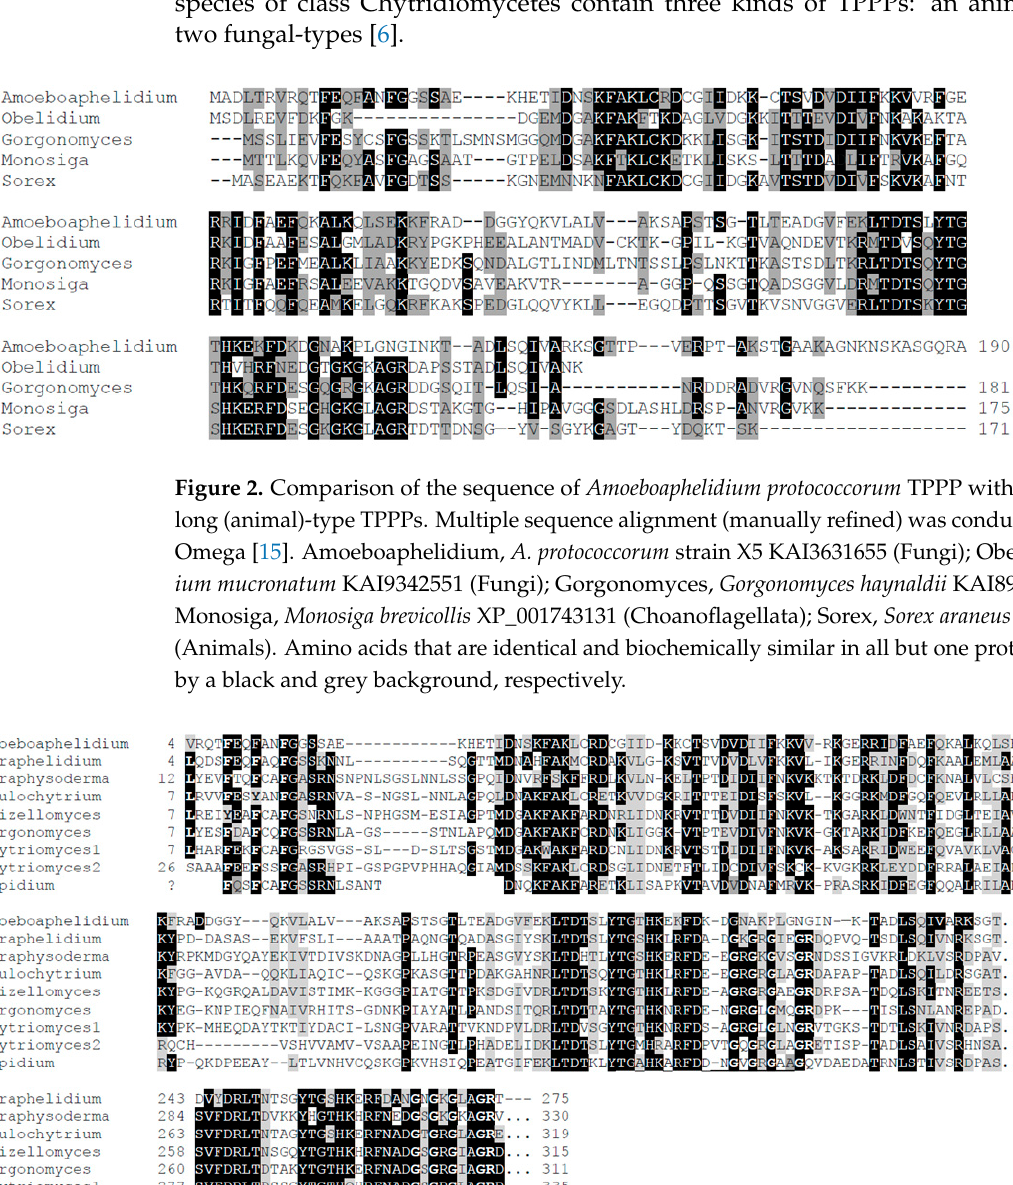
Figure 3. Comparison of the sequence of Amoeboaphelidium protococcorum TPPP with those of some fungal-type TPPPs. The multiple alignment (manually refined) of the sequences of p25alpha do- mains was conducted by Clustal Omega [15]. The N-termini (amino acids before the p25alpha domain) and the interdomain parts are not included in the alignment. Amoeboaphelidium, A. pro- tococcorum strain X5 KAI3631655; Paraphelidium, Paraphelidium tribonematis TRINITY_DN24782; Paraphysoderma, Paraphysoderma sedebokerense KAI9140125; Caulochytrium, Caulochytrium protoste- lioides RKP02545; Spizellomyces, Spizellomyces punctatus XP_016604112; Gorgonomyces, Gorgonomyces haynaldii KAI8912588; Chytriomyces1, Chytriomyces confervae TPX65886; Chytriomyces2, Chytriomyces confervae TPX72533; Olpidium, Olpidium bornovanus KAG5460860 + KAG5458366. Amino acids that are identical and biochemically similar in at least three quarters of the fungal-type proteins are labeled by a black and grey background, respectively. The “Rossman-like” sequences, GXGXGXXGR, and the LXXF(Y)XXF(Y)XXF sequence at the beginning of the p25alpha domain are indicated by bold